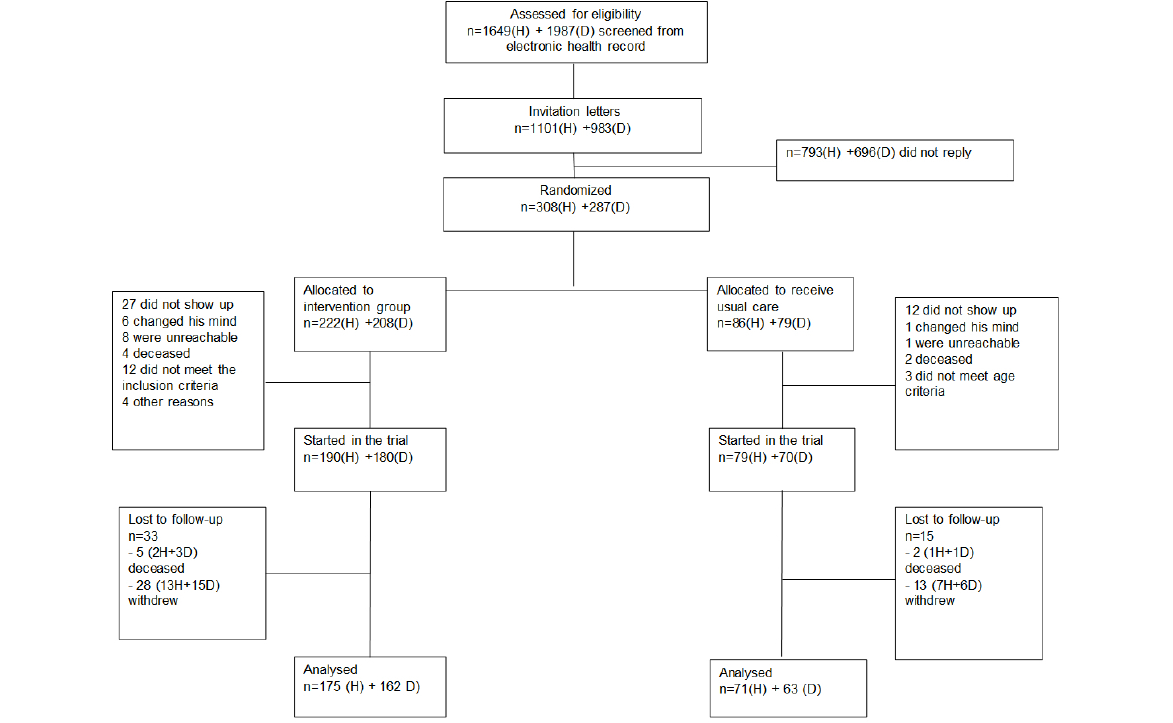
Figure 2. The patient flow within the trial. H: patients with a diagnosis of ischemic heart disease or heart failure, D: patients with a diagnosis of diabetes mellitus type 2 and HbA1c >